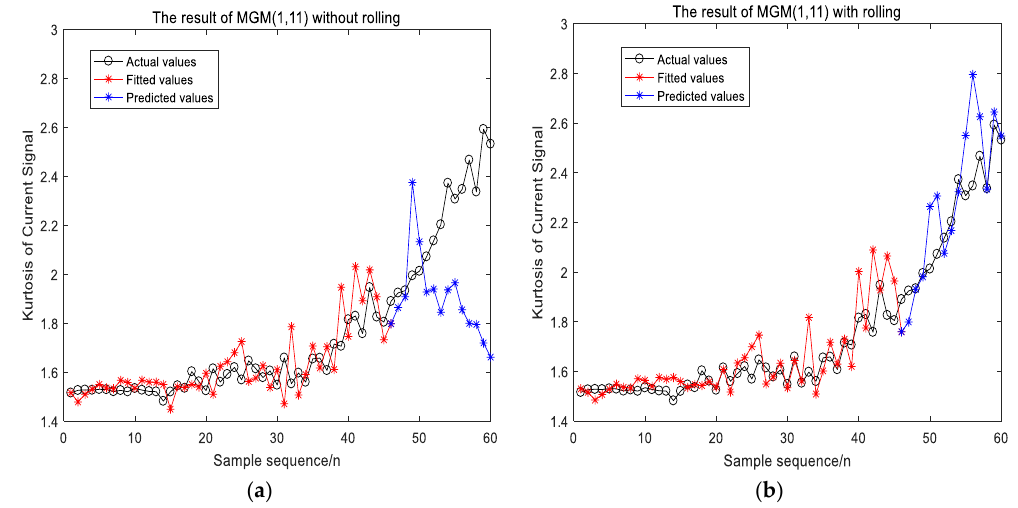
Figure 6. The result of MGM (1,11) and IMGM (1,11) for the current signal. ( a ) The result of MGM (1,11); ( b ) the result of IMGM (1,11).